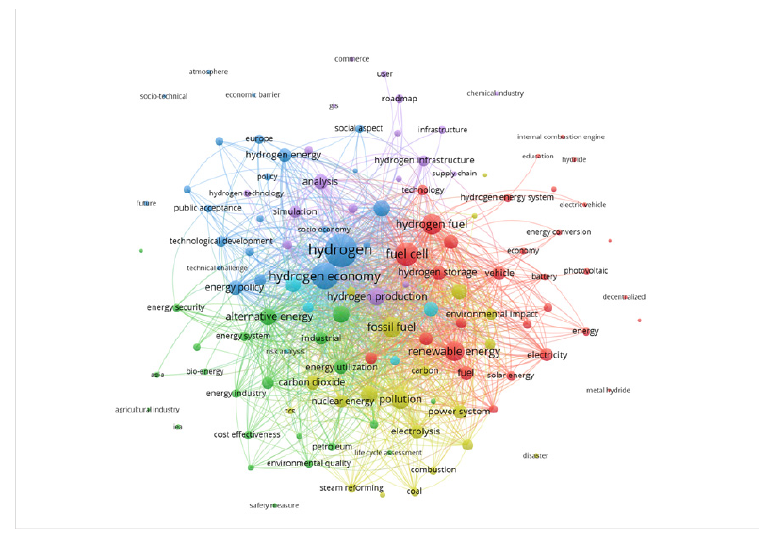
Figure 5. Keyword network map for 2000 to 2009.